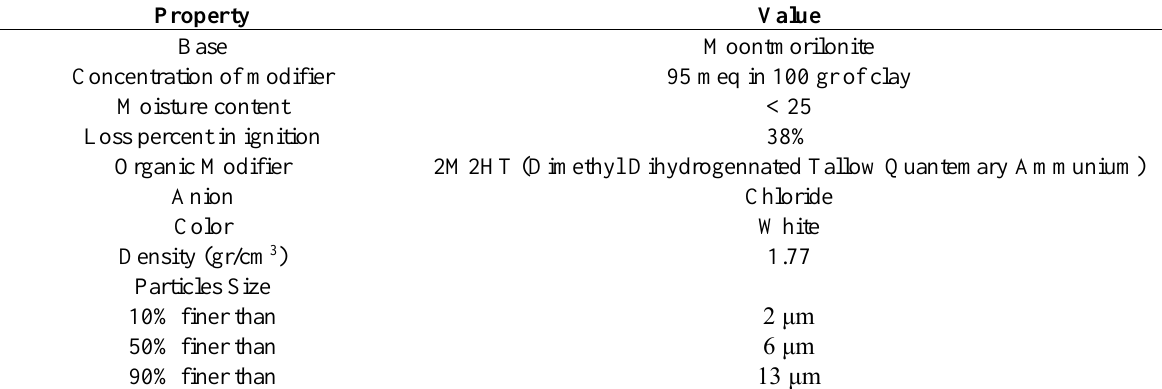
Table 4. Properties of nanoclay Cloisite